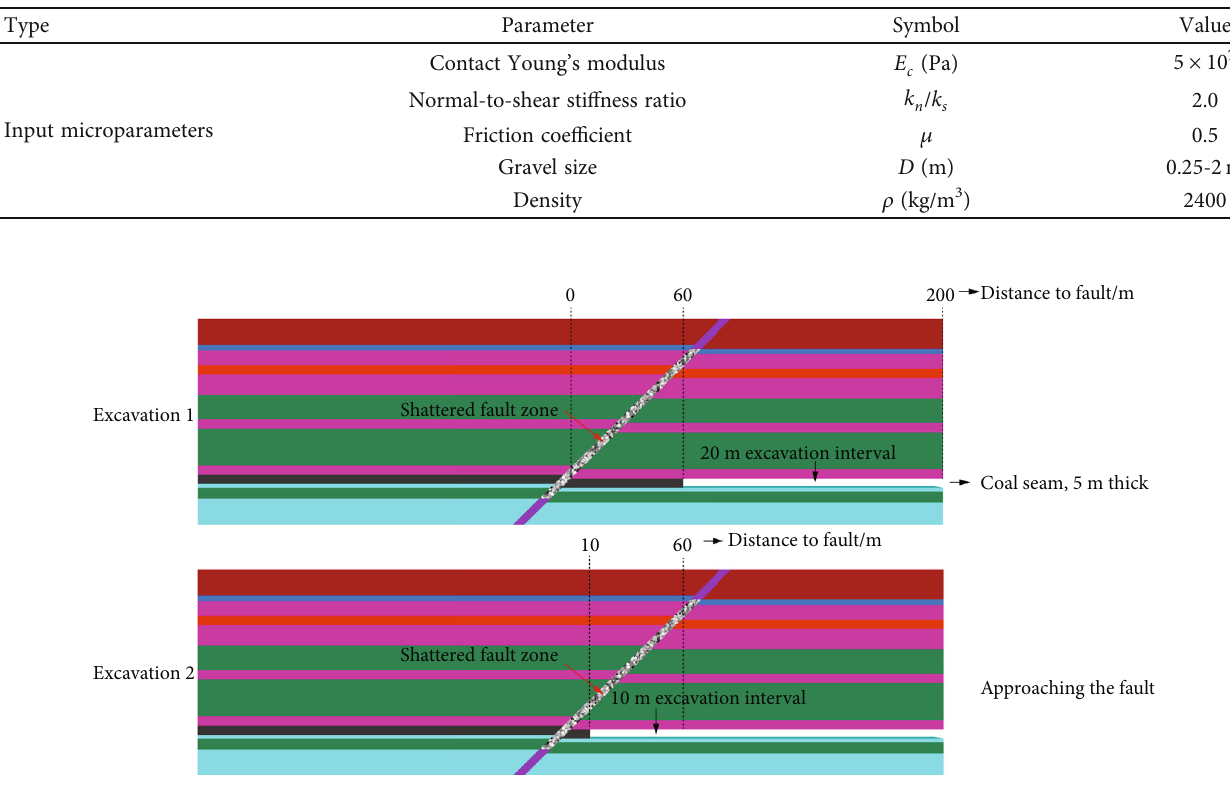
Figure 4: Excavation sequence design of the longwall working face.